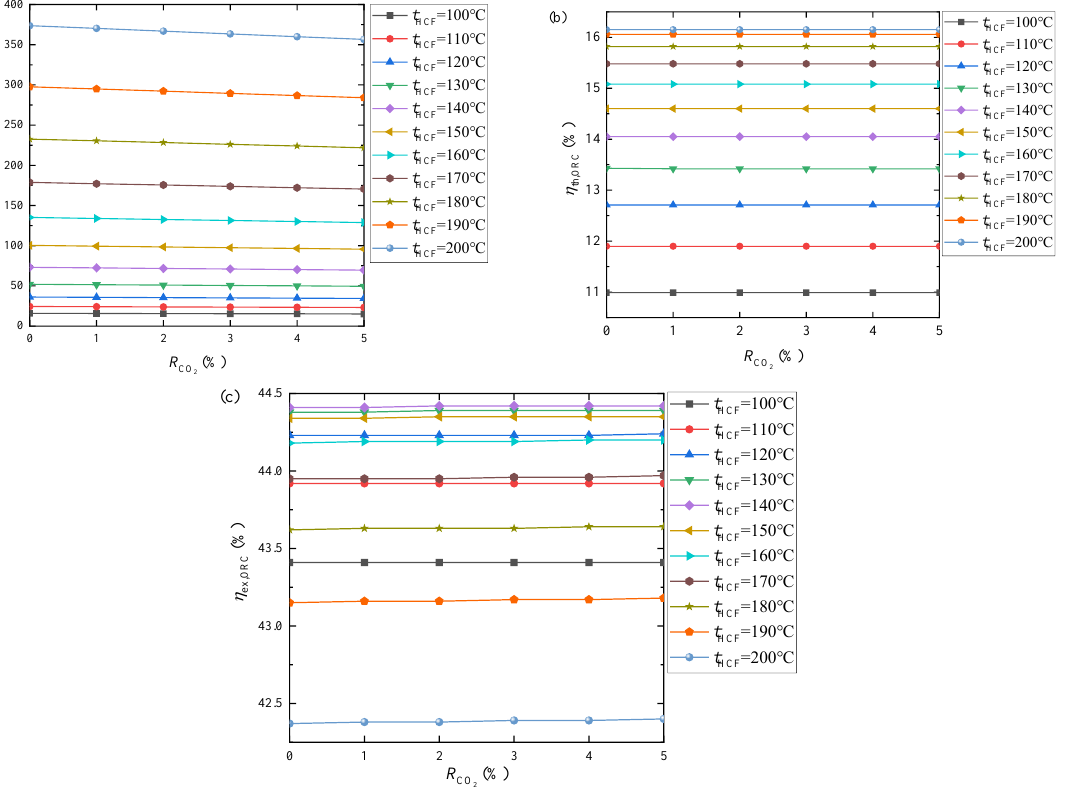
Figure 20. Variation of optimal thermodynamic parameters of the ORC system with R CO2 at different heat carrier temperatures: ( a ) W net, ORC , ( b ) η th, ORC and ( c ) η ex, ORC . The variation curves of the optimal thermodynamic parameters of the SFORC system with R CO2 at different heat-carrying fluid temperatures are shown in Figure 21. The correlation between the thermodynamic parameters of the SFORC system and both the temperature and R CO2 of the heat-carrying fluid is similar to the SF system. The influence of non-condensable gas on the flash generation process is greater, while the influence on the mass flow rate of generated liquid heat-carrying fluid is smaller, which is used as the heat source for the ORC system. Therefore, the system performance of the SFORC system has improved relative to the SF system, but the improvement is slight. When the heat-carrying fluid temperature is 200 ◦ C and R CO2 is 0, the net power output reaches the maximum which is 557.2 kW, and the maximum of exergy efficiency is 60.13%, while the maximum thermal efficiency is 24.11% when R CO2 equals 5%. After the heat-carrying fluid is flashing, all that enters the SF system, the ORC sub- system and the SF subsystem of the SFORC system is single-phase fluid, and there is no violent phase change of the heat-carrying fluid during the heat transfer process. The state of the heat source corresponding to the pinch point is easy to determine. In contrast,